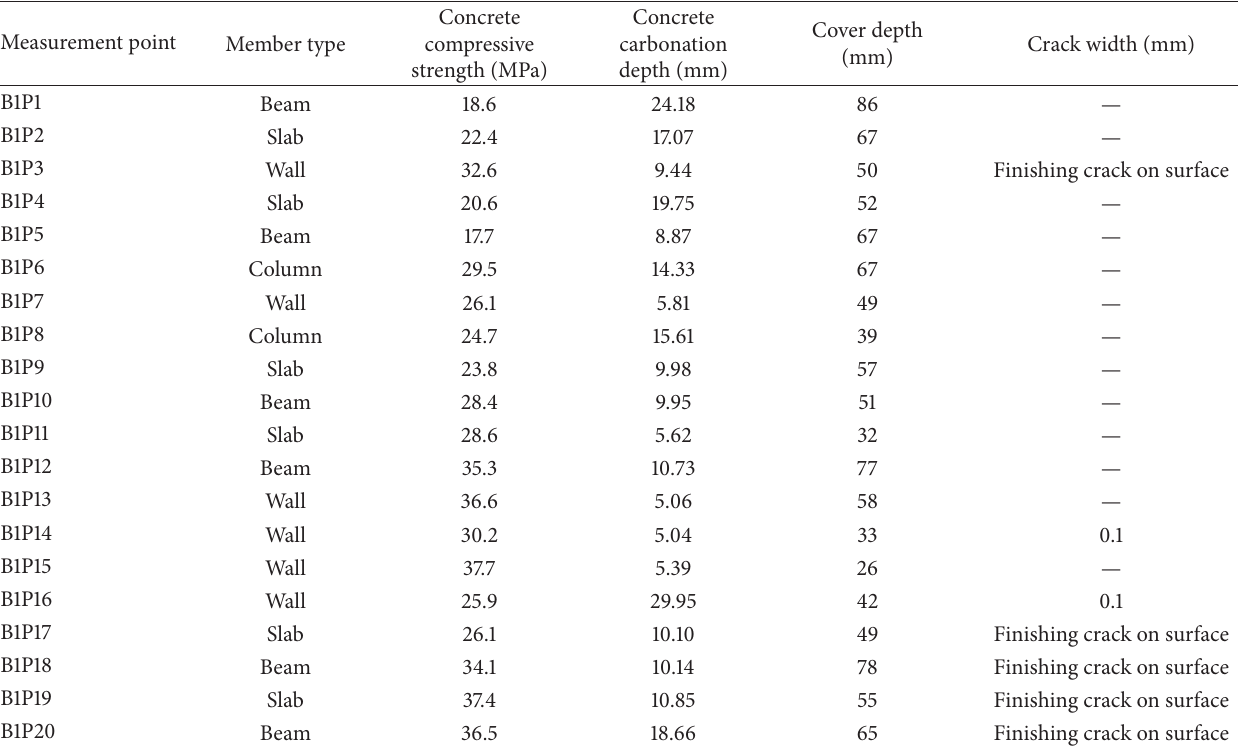
Table 3: Field investigation data (Building 1, construction completion year: 1981).